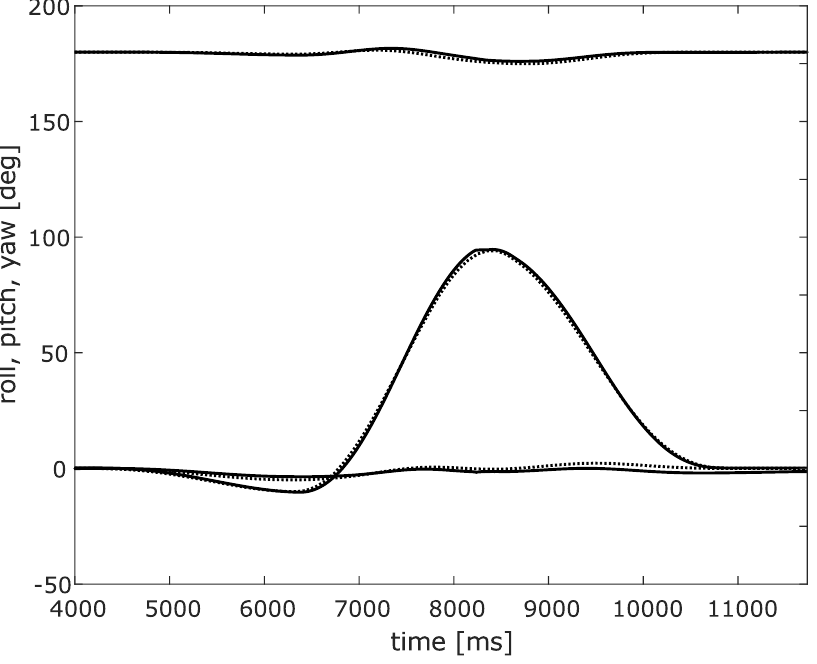
Figure 6. Roll, pitch yaw values of the lower leg analogue of the RTS filtered IMU data (full lines) and robot logged values (dashed